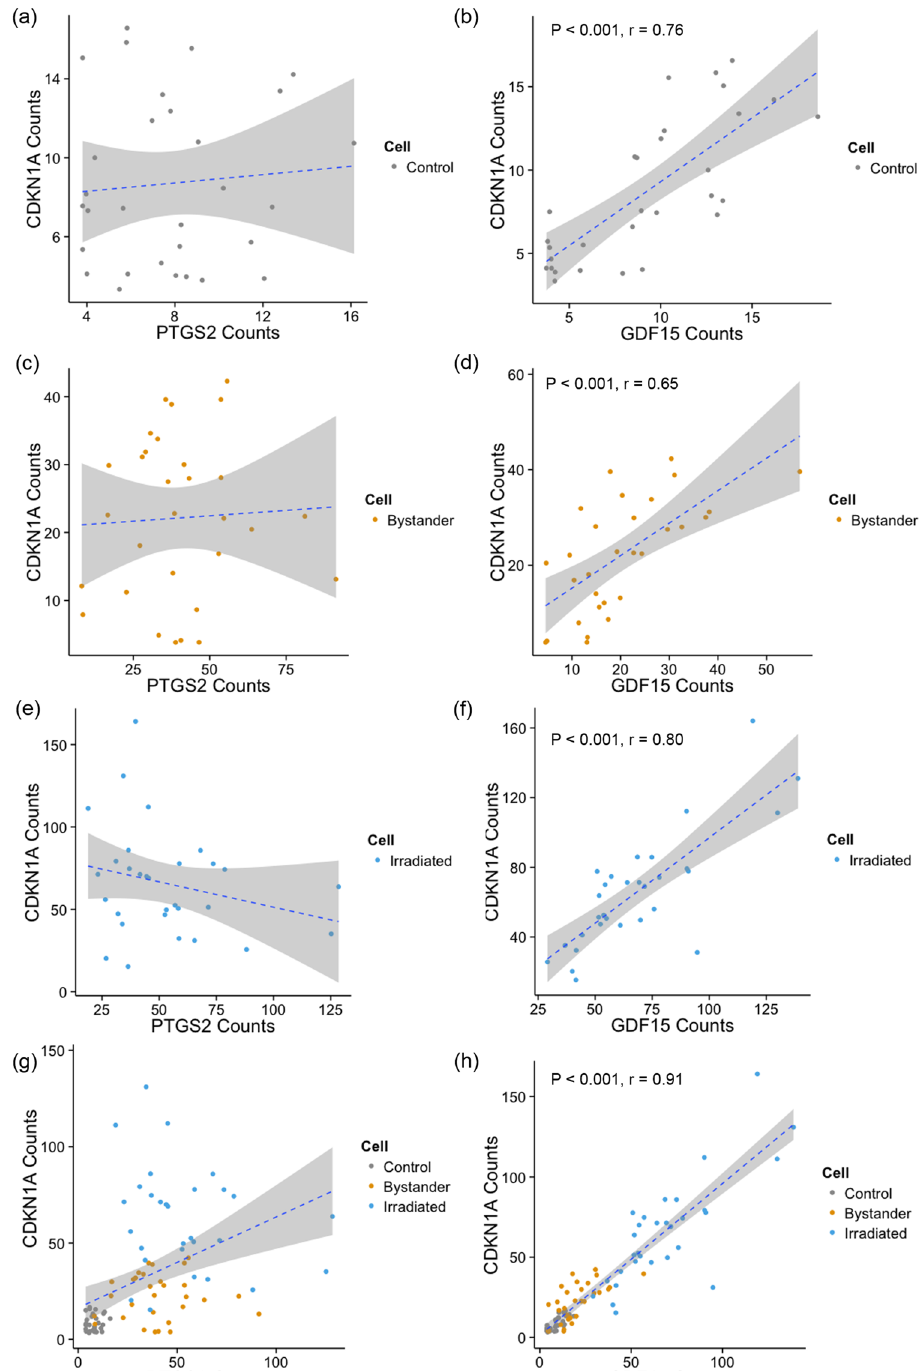
Figure 5. Scatter plots of expression levels of CDKN1A against PTGS2 ( a , c , e , g ) and CDKN1A against GDF15 ( b,d,f,h ). Grey shading represent 95% confidence level interval for predictions from a linear model (blue dashed